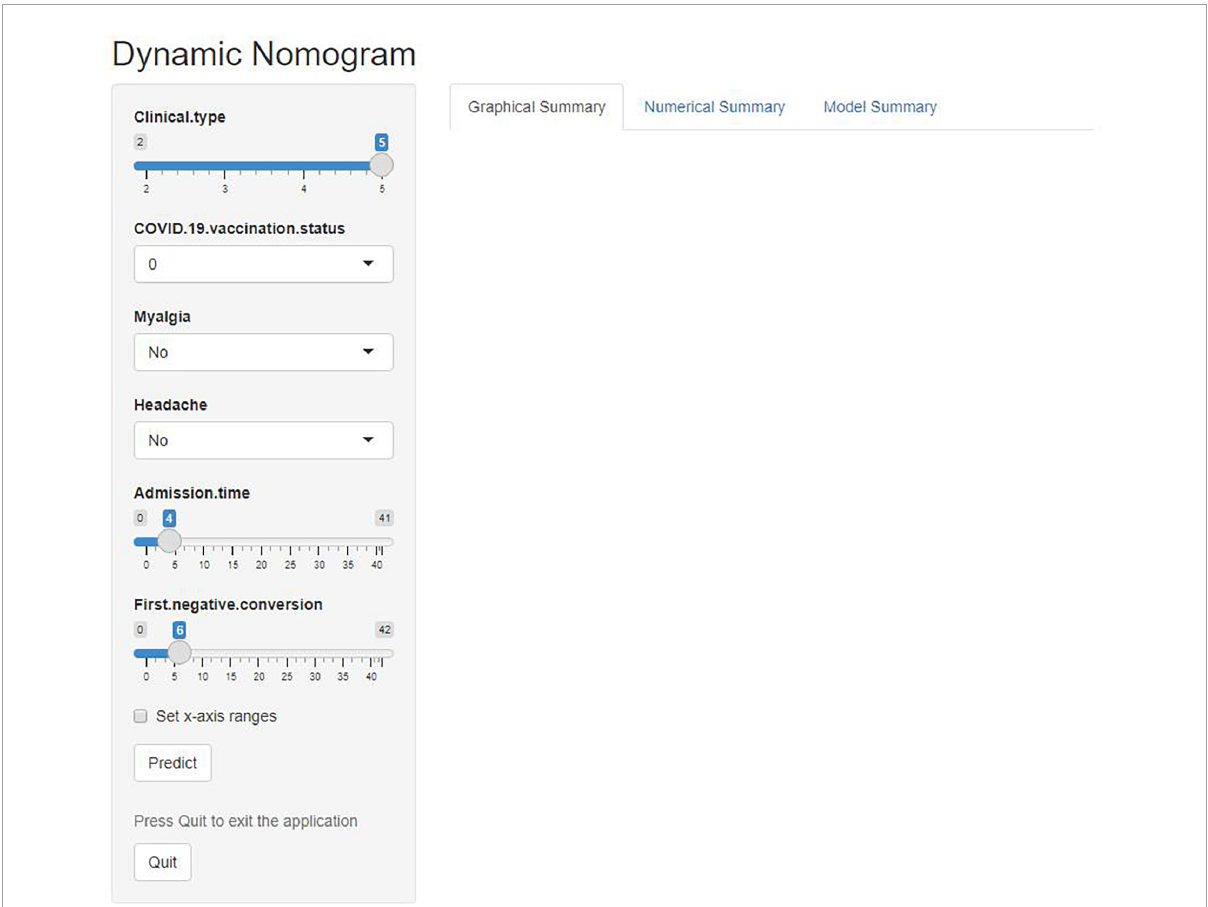
FIGURE2 An online calculator was developed to automatically calculate the risk of re-testing positivity among non-critical individuals within 30 days by entering the values of the six variables. Clinical type: 2—Severe, 3—General, 4—Mild, and 5—Asymptomatic. COVID-19 vaccine status: 0—Unvaccinated, 1—Partially vaccinated, 2—Primarily vaccinated, and 3—Completely